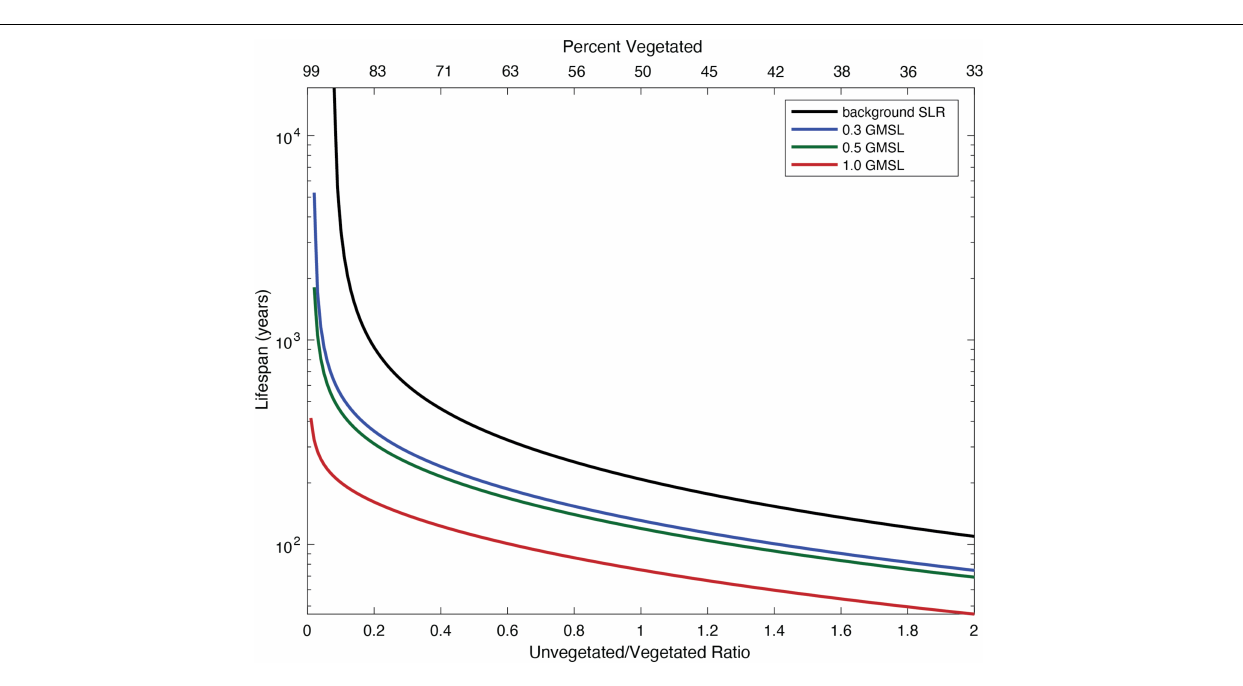
FIGURE 4 | Estimated lifespan (per Ganju et al., 2020) for varying UVVR values of the idealized model marsh in the study under background and 0.3, 0.5, and 1.0 m sea-level rise (SLR) by 2100